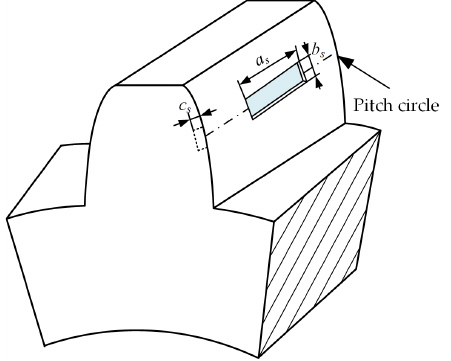
Figure 2. Schematic diagram of spalling spur gear.